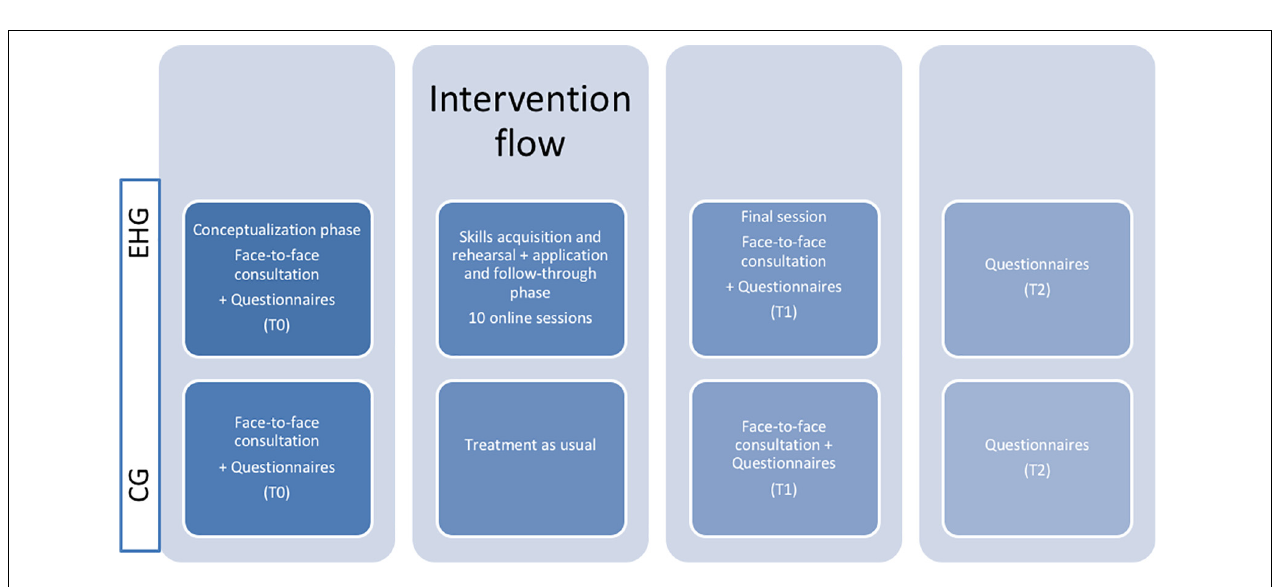
FIGURE 1 | eSIT protocol.